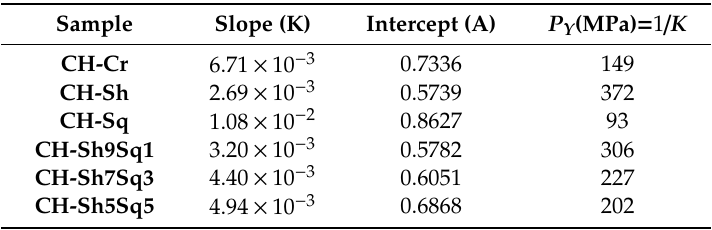
Table 6. Heckel parameters of CH-Cr, CH-Sh, and CH-Sq and their mixtures.